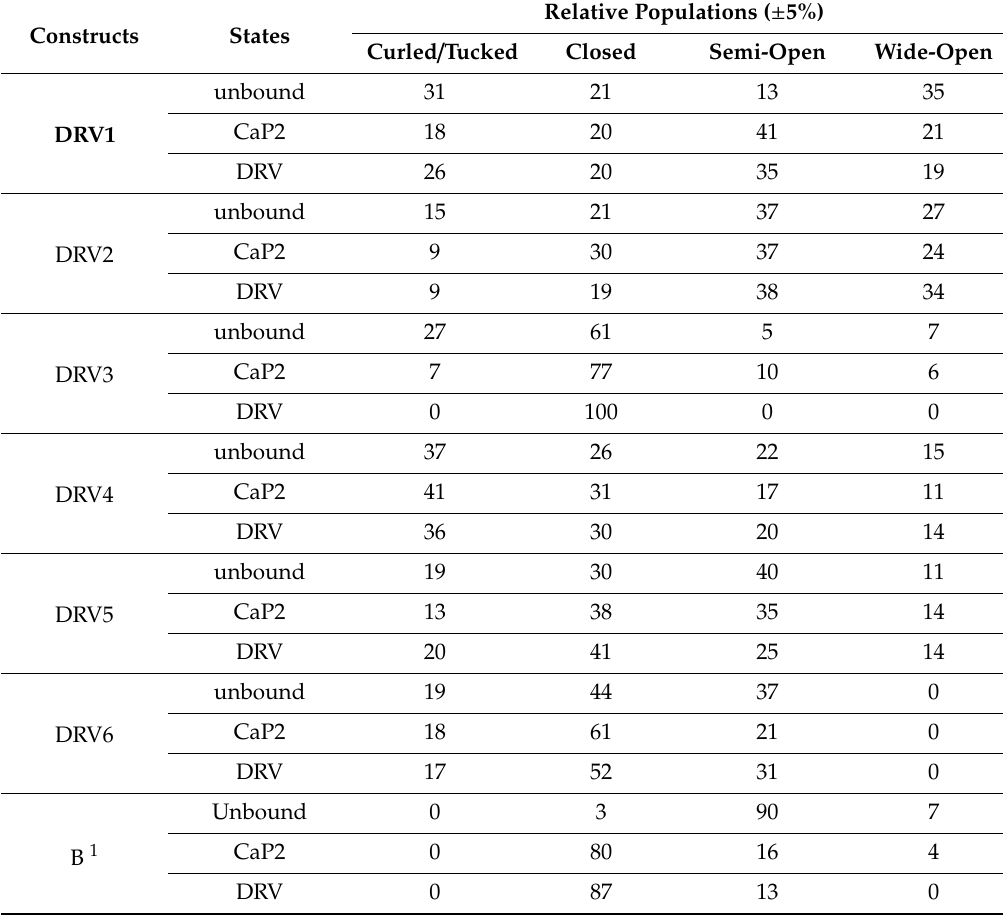
Table 2. Summary of the fractional occupancy of the four nominal states from DEER population analysis. Relative Populations ( ± 5%) Constructs States Curled / Tucked Closed Semi-Open Wide-Open